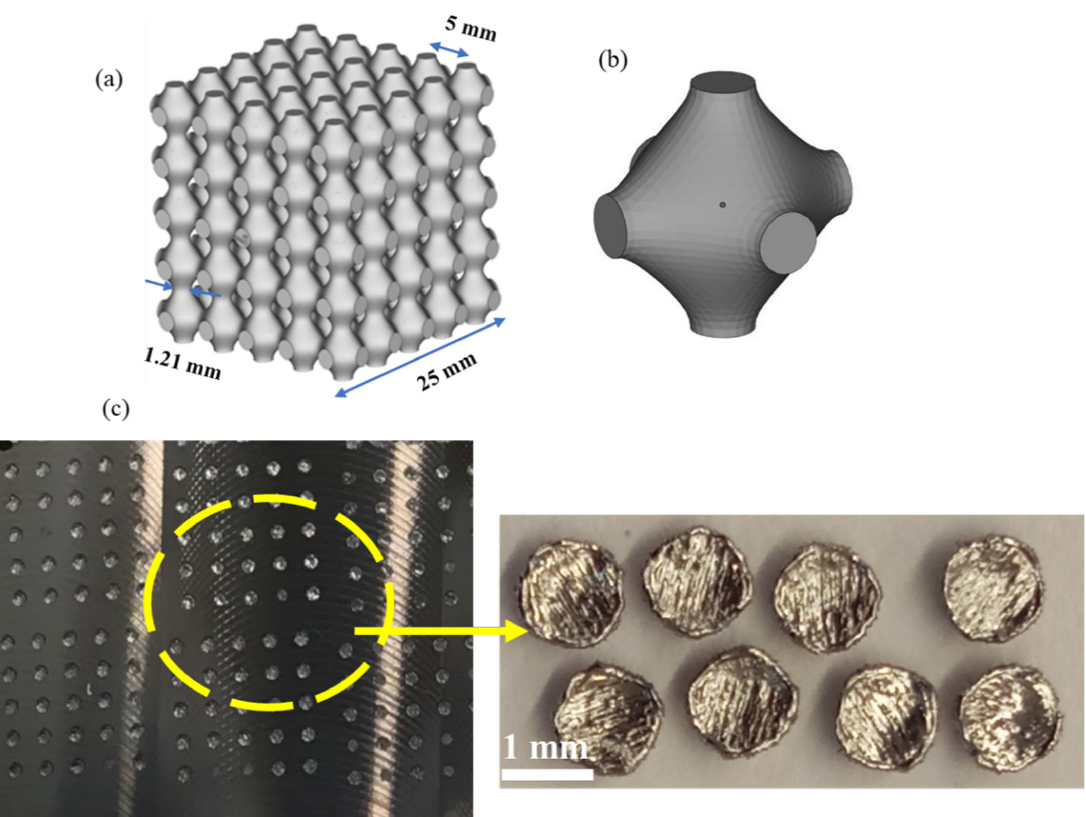
Figure 2. CAD model of the TPMS lattice showing a primitive lattice ( a ) and its corresponding unit cell ( b ). The thin TPMS layer was fabricated on a titanium-alloy base plate ( c ). Figure 3 further illustrates the sectioning of the CAD model to obtain the studied primitive lattices.